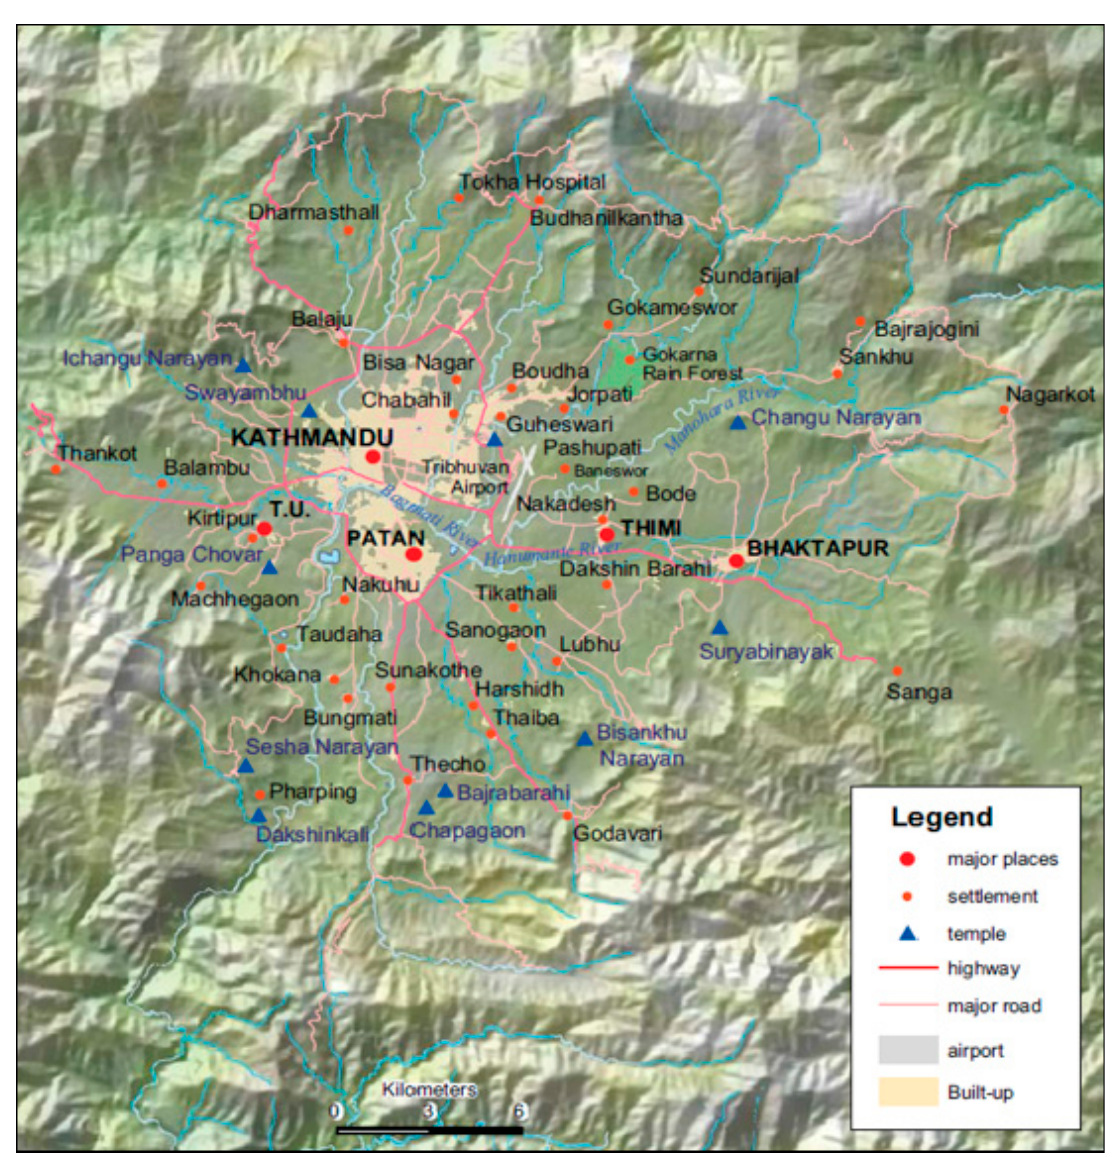
Figure 1. Map of the Kathmandu valley with its major cities [9].